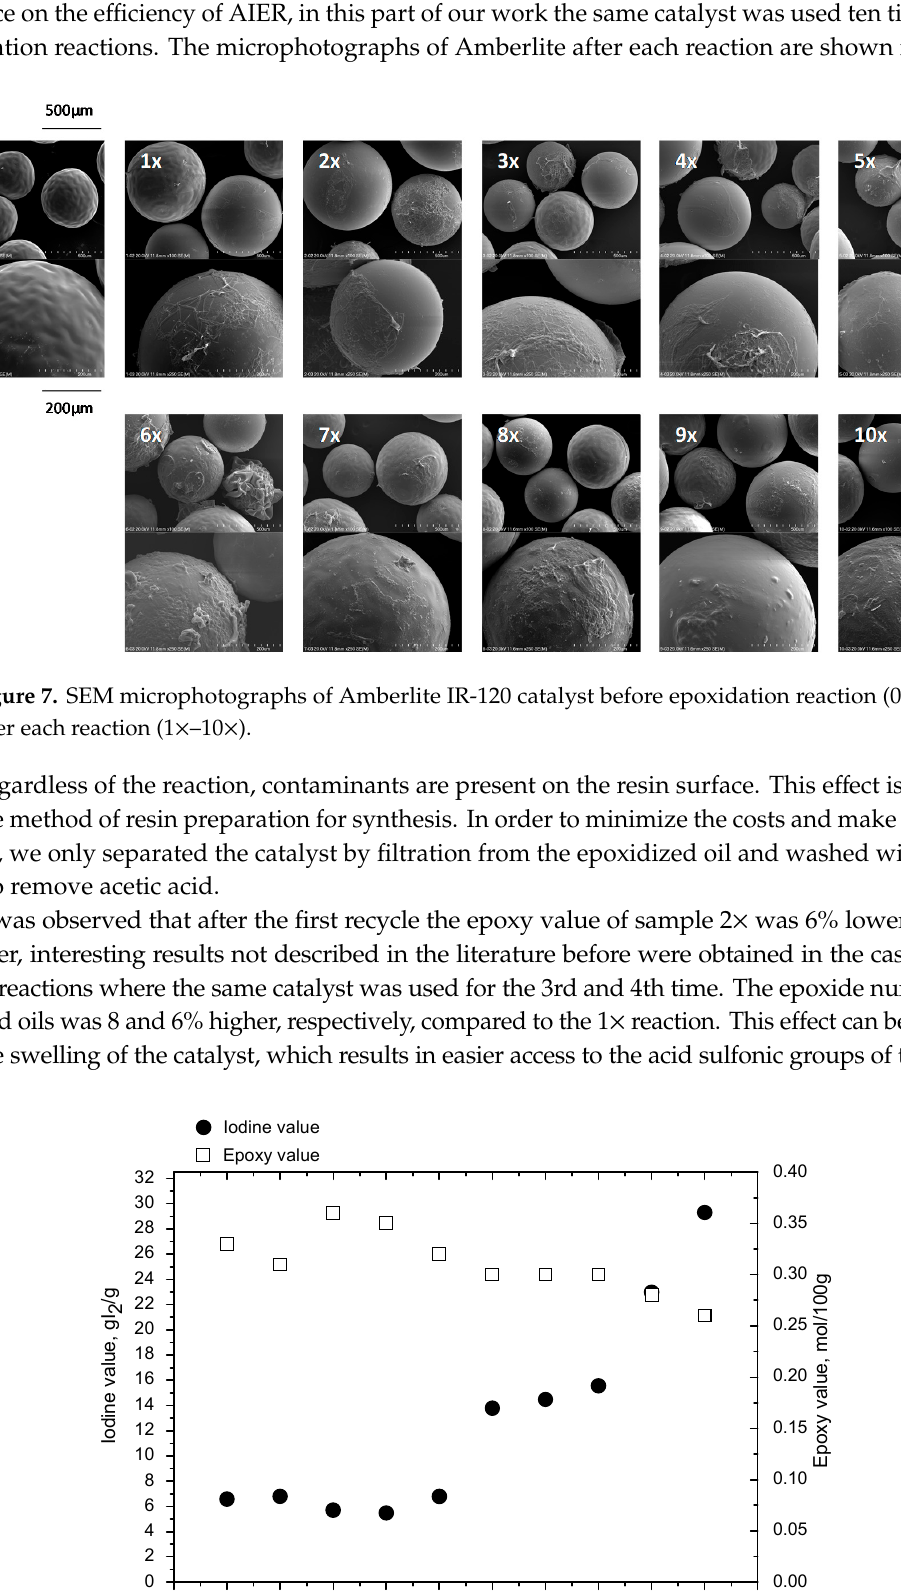
Figure 8. Changes in Ev and Iv depending on the number of times the catalyst was used.